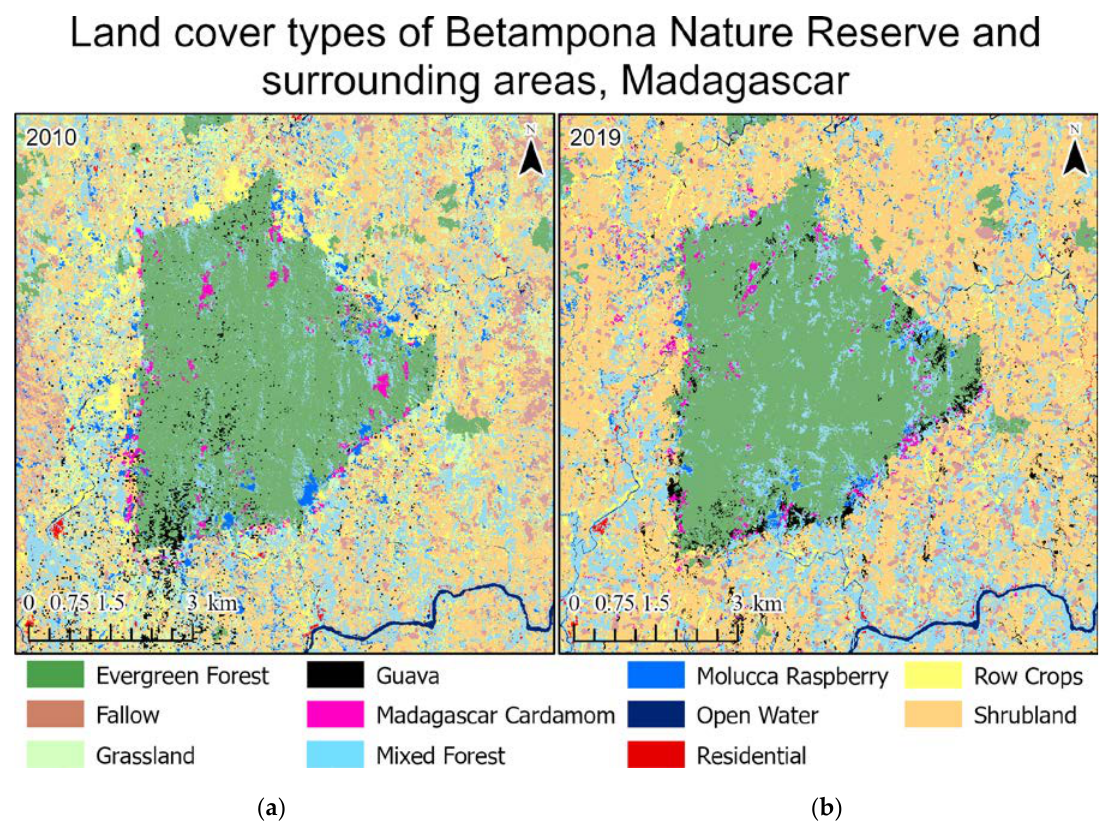
Figure 9. ( a ) The 2010 classification map and ( b ) the associated classification map created in 2019. The use of identical classes enabled the quantification of land cover change over time. Table 5. Total hectares for each class mapped in 2010 and 2019 are listed below based on overlapping extent (Figure 9), along with the amount of percent increase (or decrease) (Equation (7)) over time for each